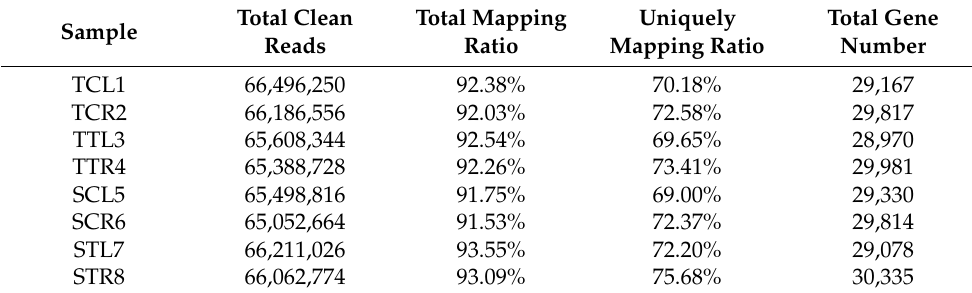
Table 3. Summary of genome mapping.